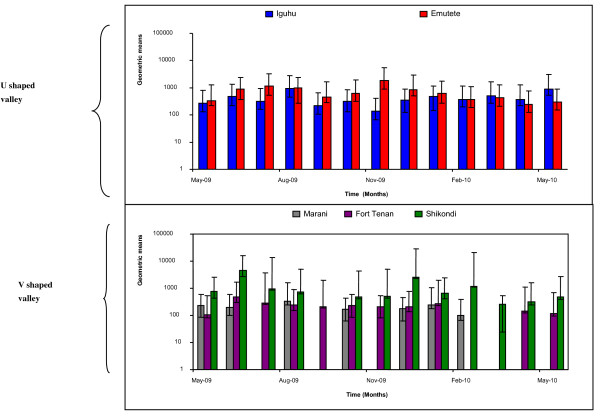
The parasite density in the five sites, the geometric mean was the highest at the plateau (Shikondi) and showed high variation in the parasite density basing on the magnitude of the error bars.